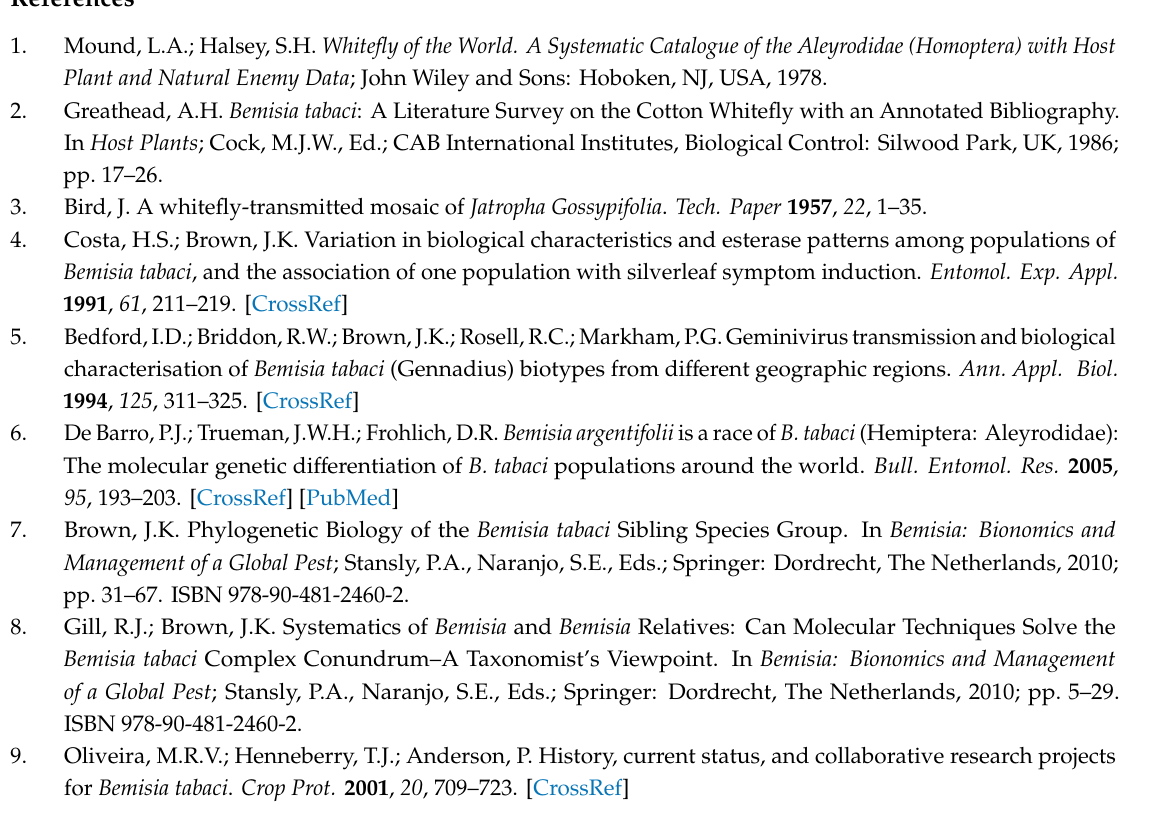
Figure S1: Result of coalescent analysis on 2184 nuclear single-copy orthologs performed with Astrid. Figure S2: Result of maximum likelihood COI analysis of publicly available data [69] and read-mapped mitochondrial sequences